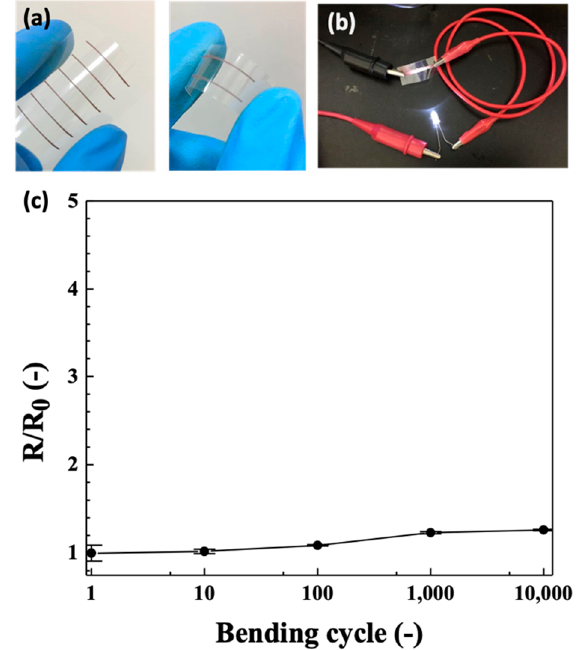
Figure 8. ( a ) Images of printed copper tracks on PET by using CuNP / CuONP ink. ( b ) LED light connected with the printed tracks. ( c ) Bending test for the printed tracks. A bending radius of 1 cm is used in this test.